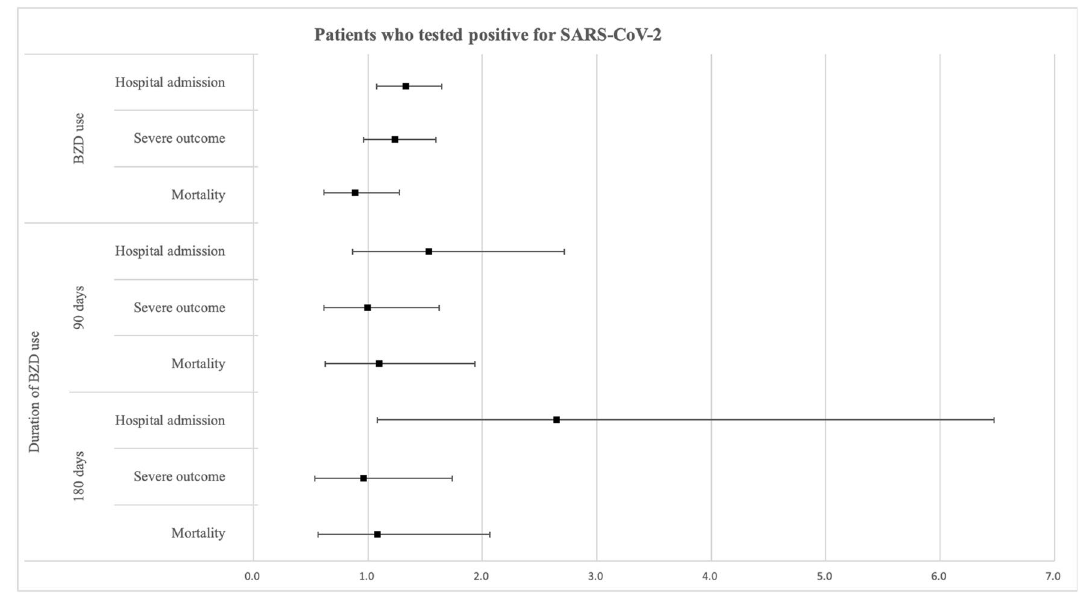
Figure 2. The results of the analysis of the association between benzodiazepine use and clinical outcomes. BZD